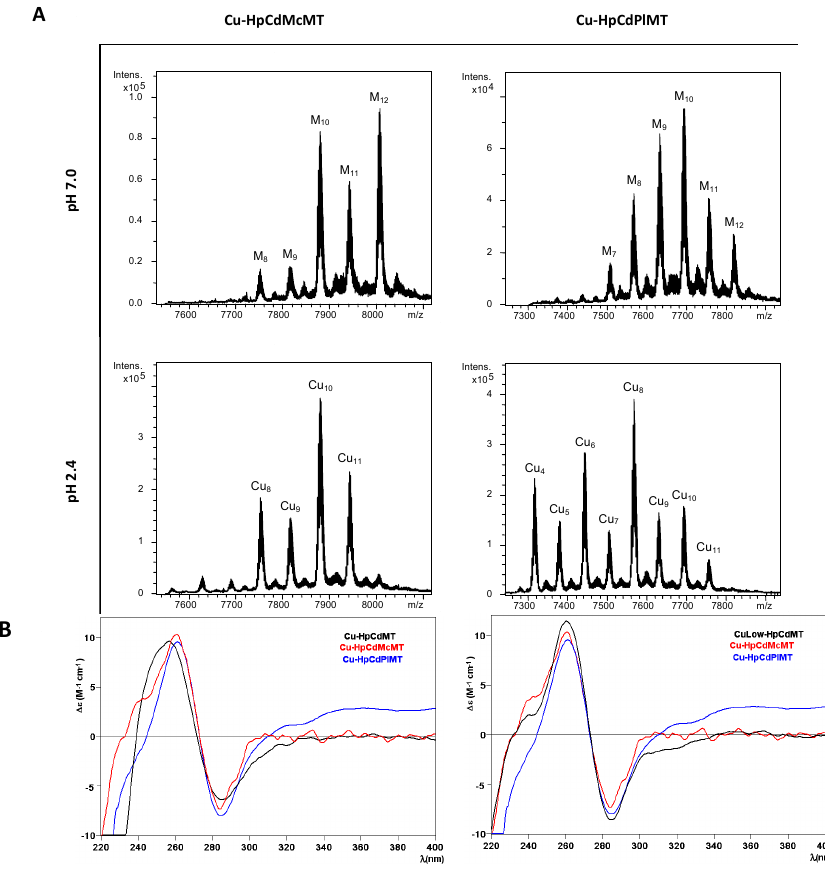
Figure 5. Analysis of the Cu-HpCdMcMT and Cu-HpCdPlMT complexes. ( A ) Deconvoluted ESI-MS spectra of the recombinant preparations of HpCdMcMT and HpCdPlMT purified from Cu-supplemented cultures, analyzed at neutral pH (7.0); ( B ) CD spectra of the same recombinant preparations. For comparative purposes, the CD spectra of the corresponding recombinant preparations yielded by the wild-type HpCdMT protein [15] have been included.